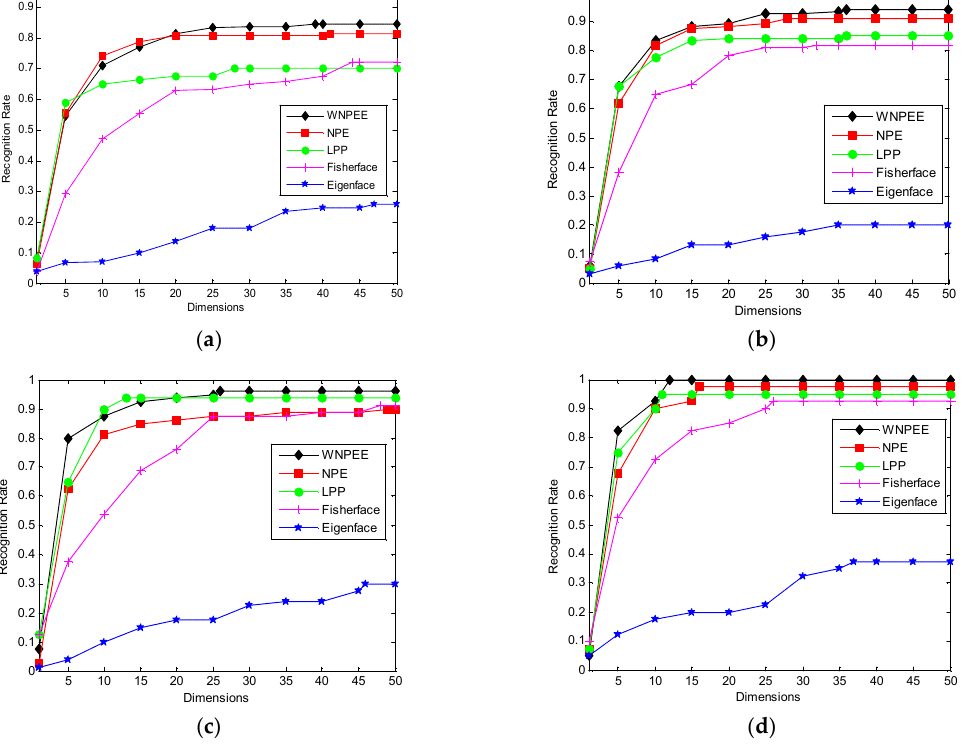
Figure 2. Average recognition rate versus reduce dimensions on ORL dataset. ( a ) l = 4, ( b ) l = 5, ( c ) l = 6, and ( d ) l = 7.